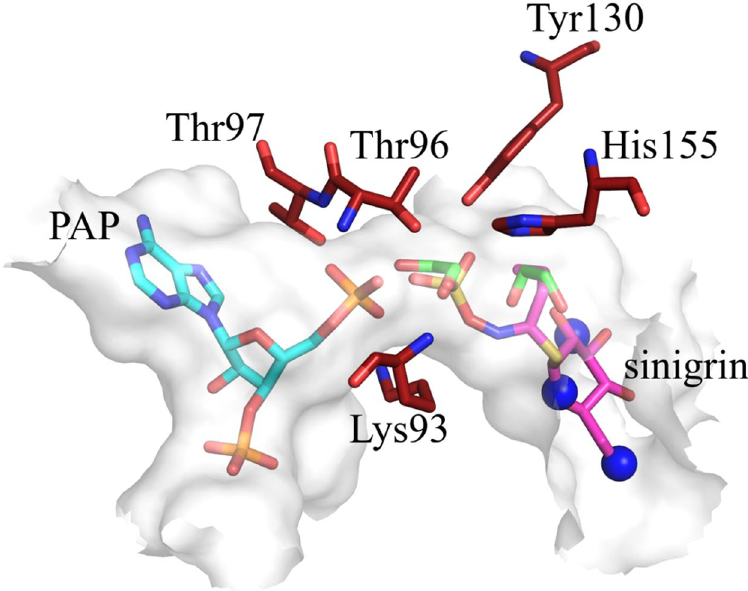
Figure 4. Close up of the binding site with residues of the catalytic centre. Catalytic residues (red) with bound sinigrin (magenta), PAP (cyan) and protein surface (light grey). Several atomic positions occupied by the polar groups of sinigrin in the AtSOT18 • PAP • sinigrin complex, including the sulphate moiety, are filled with solvent molecules (water: blue spheres; ethane-1,2-diol: green sticks) in the AtSOT18 • PAP complex